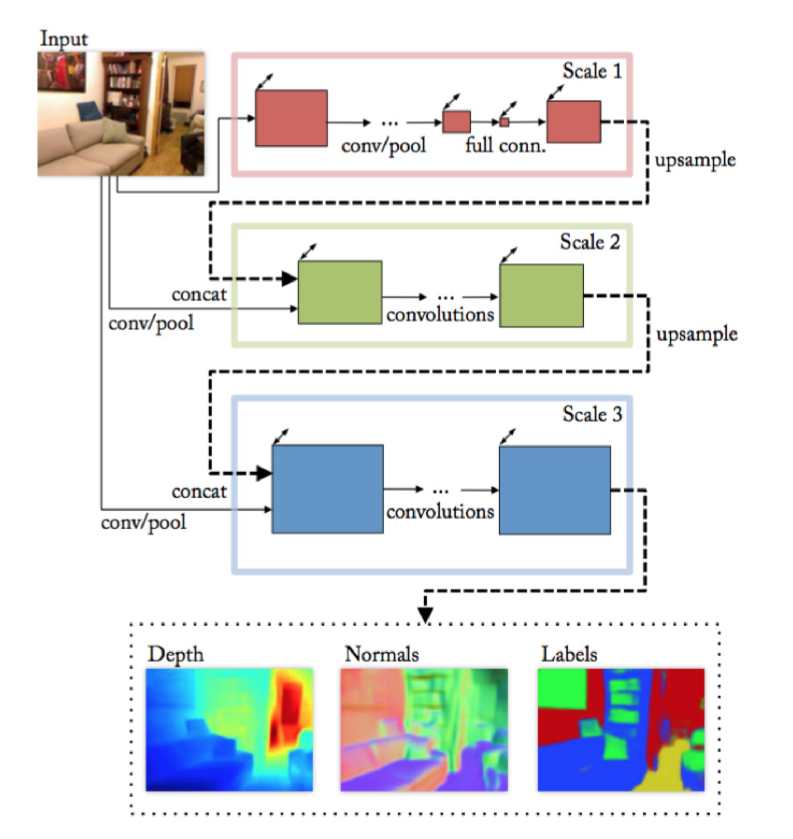
Figure 9. The hybrid architecture proposed in Eigen